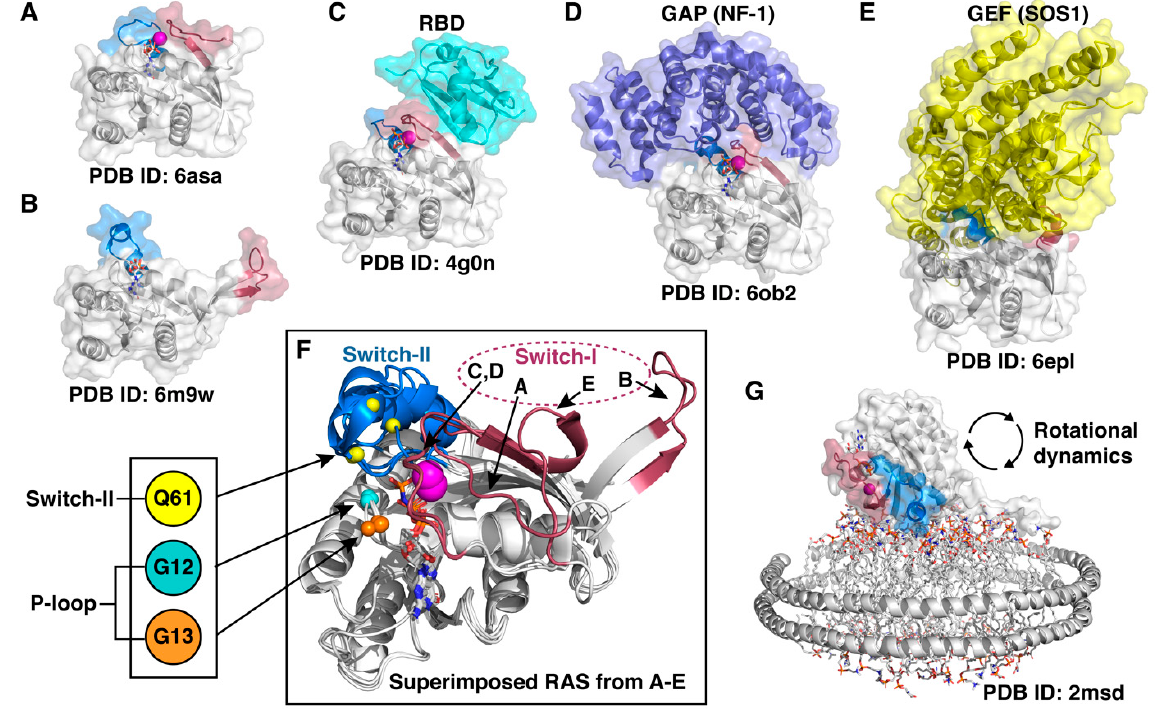
Figure 4. RAS displays remarkable conformational flexibility and adaptability. ( A ) State 1 conformation of RAS, also known as an open state [116]. ( B ) Fully open switch-I conformation that exemplifies the high intrinsic capability of the switch mobility [117]. ( C ) RAS appears in a closed conformation (also known as state 2) in complex with effector proteins; here demonstrated by a complex of HRAS with RBD (RAS binding domain) of Raf kinase [118]. ( D ) A closed conformation of RAS is also observed in a GAP–RAS complex [119]. ( E ) GDP is displaced from RAS upon binding of GEF that binds to an open switch-I RAS conformation and introduces an α -helix into the nucleotide-binding site [120]. ( F ) Superimposed RAS structures from ( A – E ) highlight the switch dynamics. Oncogenic mutation hotspot locations (C α -atoms) are indicated with small spheres. ( G ) NMR data-driven model of RAS on a lipid nanodisc [121]. In all ( A – G ): Switch-I (residues 30–40) region is highlighted with red and switch-II (58–72) with blue; Mg 2+ -ion is displayed as a magenta sphere; the bound nucleotide is shown in sticks.